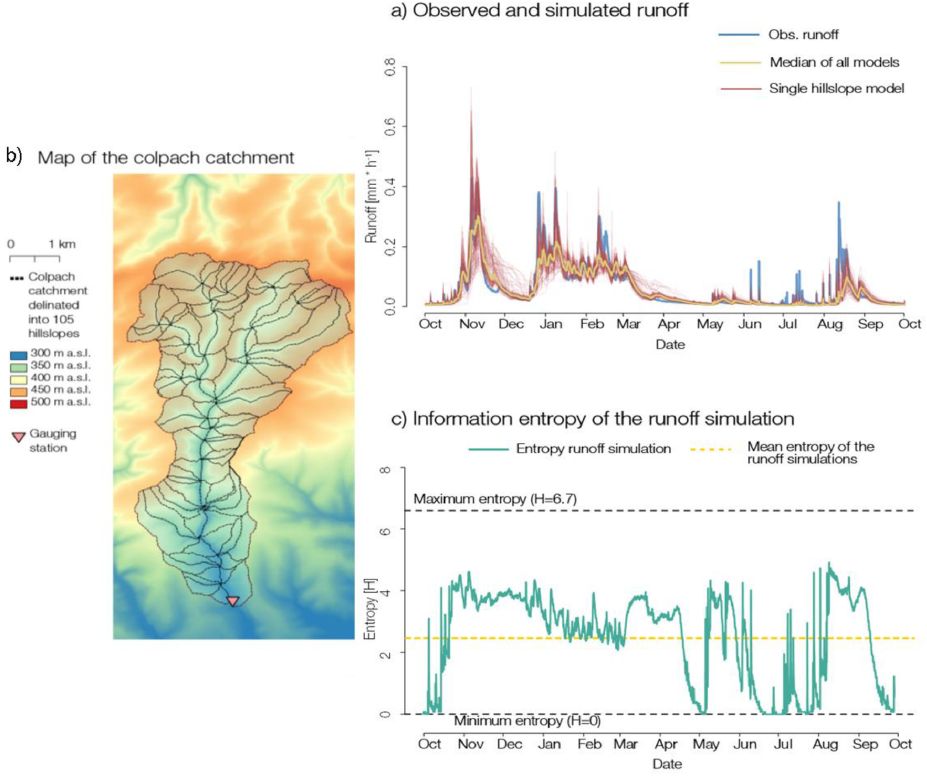
Figure 2. (a) Observed and simulated runoff of the Colpach catchment. The red lines correspond to individual hillslope models and the yellow line to the area-weighted median of all hillslopes. (b) Map of the Colpach catchment and the 105 different hillslopes. (c) Shannon entropy in turquoise for the runoff simulations as well as the corresponding mean. © Ralf Loritz, KIT; from Loritz et al.